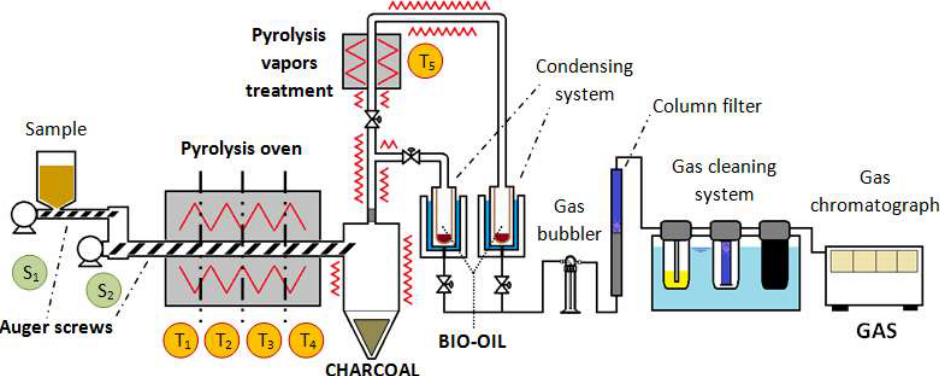
Figure 3. Pyrolysis installation.